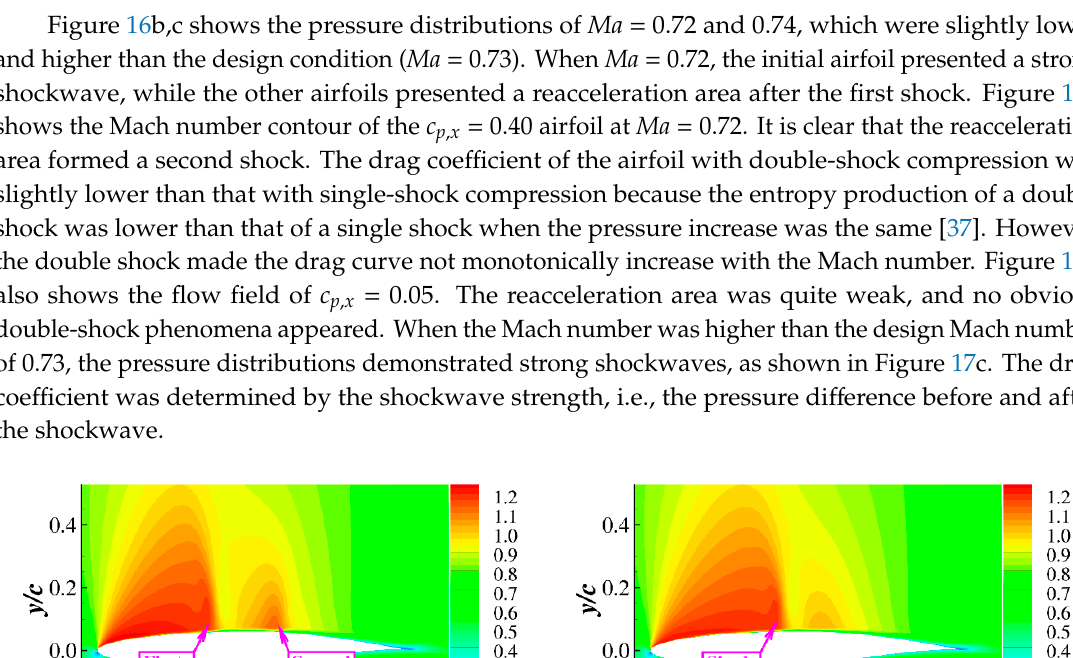
Figure 17. Flow fields of airfoils at Ma = 0.72, Re = 6.5 × 10 6 , C L = 0.800. ( a ) c p,x = 0.40; ( b ) c p,x = 0.05.